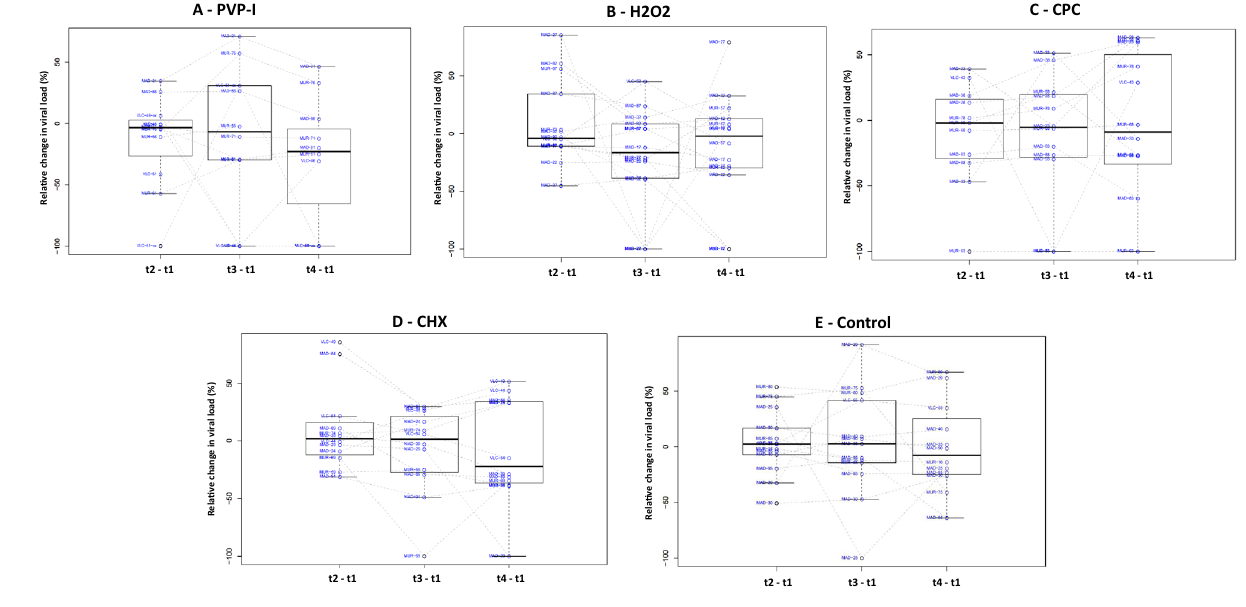
Figure 4. Relative changes in salivary viral load for all five treatment groups after the mouthwash. Box plots show changes of viral load (%) for each of the patients in the group A—PVP-I (povidone-iodine), B—H 2 O 2 , C— CPC (cetylpyridinium chloride), D—CHX (chlorhexidine) and E (placebo group) at the three different times after the oral rinse treatment, relative to the baseline viral load prior to the mouthwash (changes at 30 min: t2– t1; changes at 60 min: t3–t1; changes at 120 min: t4–t1). Lines joining the points from the same patient through time are also shown.